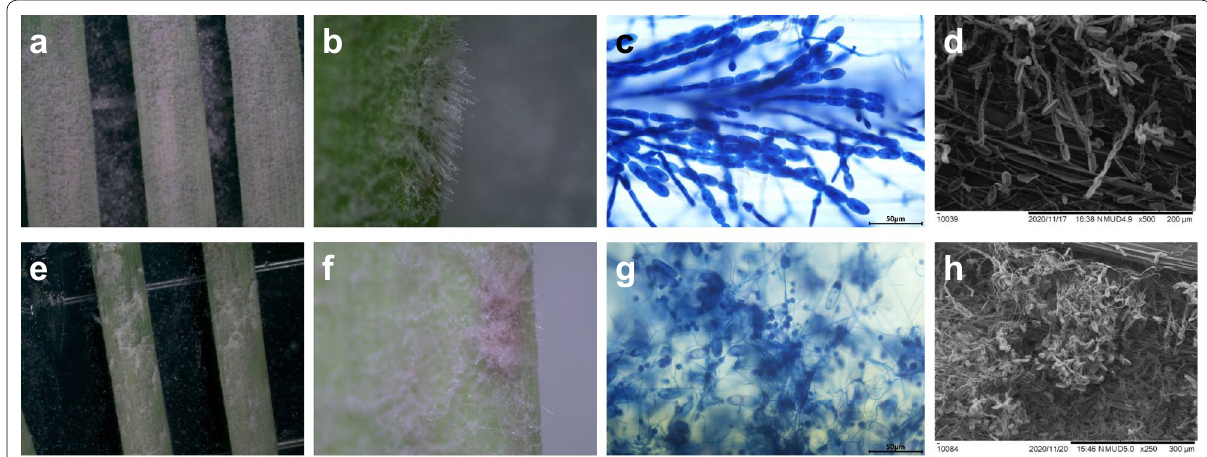
Fig. 1 Morphological characteristics of Blumeria graminis f. sp. tritici ( Bgt ) colonies. a – d Natural Bgt colonies. e – h Parasitized Bgt colonies. The colonies were monitored under a stereomicroscope ( a , b , e , f ), light microscope ( c , g ) and scanning electron microscope ( d , h ). Scale bars g ), 200 ( d ), or 300 μm ( h